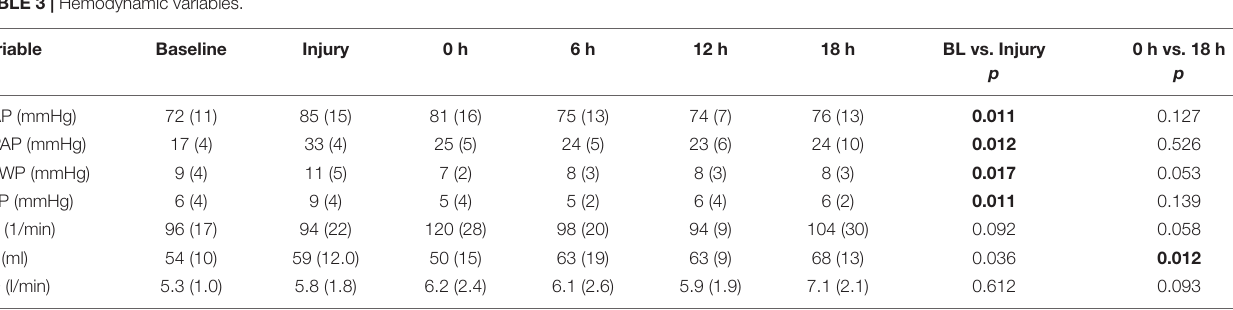
FIGURE 7 | Relative lung aeration. Different degrees of lung aeration, expressed as % relative lung mass. TABLE 3 | Hemodynamic